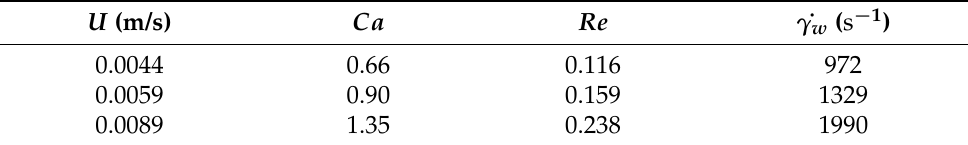
Table 1. Conditions for numerical simulation to compare the effect of the shear rate. U (m/s)